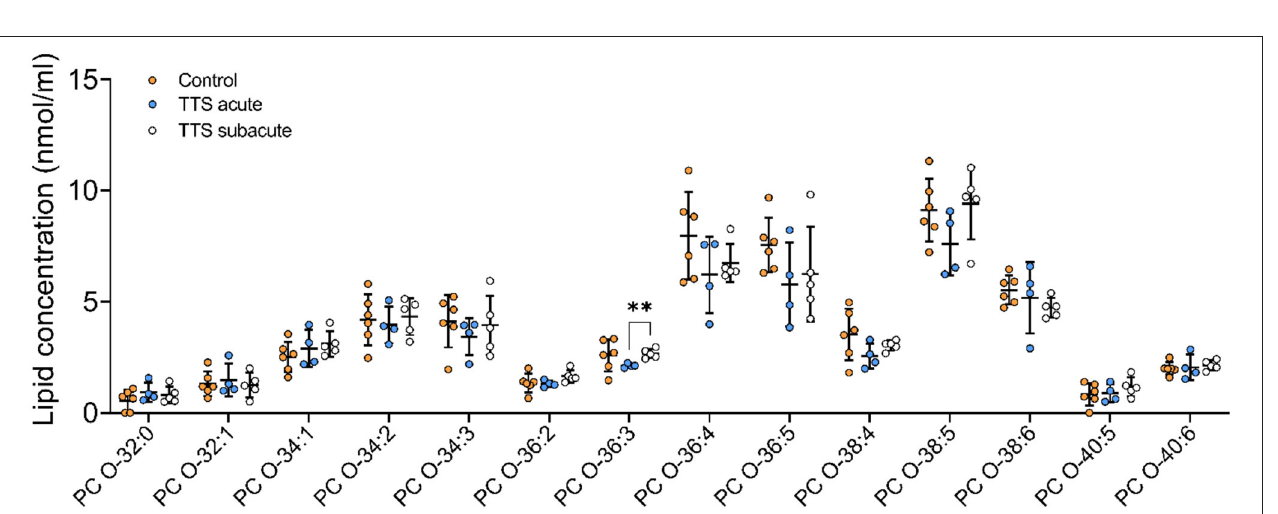
FIGURE 2 | Composition of individual phosphatidylcholine (PC) lipid species in the acute TTS, subacute TTS, and control groups. Values are represented as nmol/ml of serum. Values are mean ± SD, P -value: * P < 0.05. Where significance is not mentioned, values are considered as being not significant. PC; Phosphatidylcholine, TTS, Takotsubo syndrome.